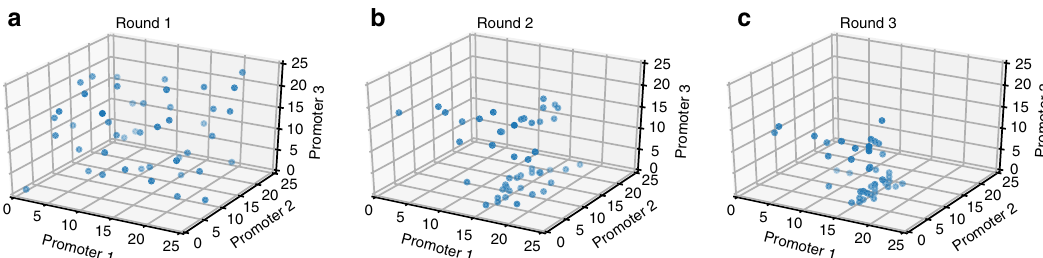
Fig. 3 Change in sampling behavior of Baysesian optimization of the lycopene production pathway. In the fi rst round ( a ), all points were chosen to uniformally explore the landscape since it is completely unexplored and unknown ( n = 46). In the second round ( b ), some information is acquired and the points picked by the algorithm are clearly skewed from the unifrom distribution ( n = 45). However, since there is some uncertainty, it is still exploring the landscape. Finally, in the third round ( c ), a clear pattern is observed where the algorithm has determined the points in a particular area are more likely to be closer to the global optima and is actively exploring that area but still doing some minimal exploration ( n = 45). Source data are provided as a